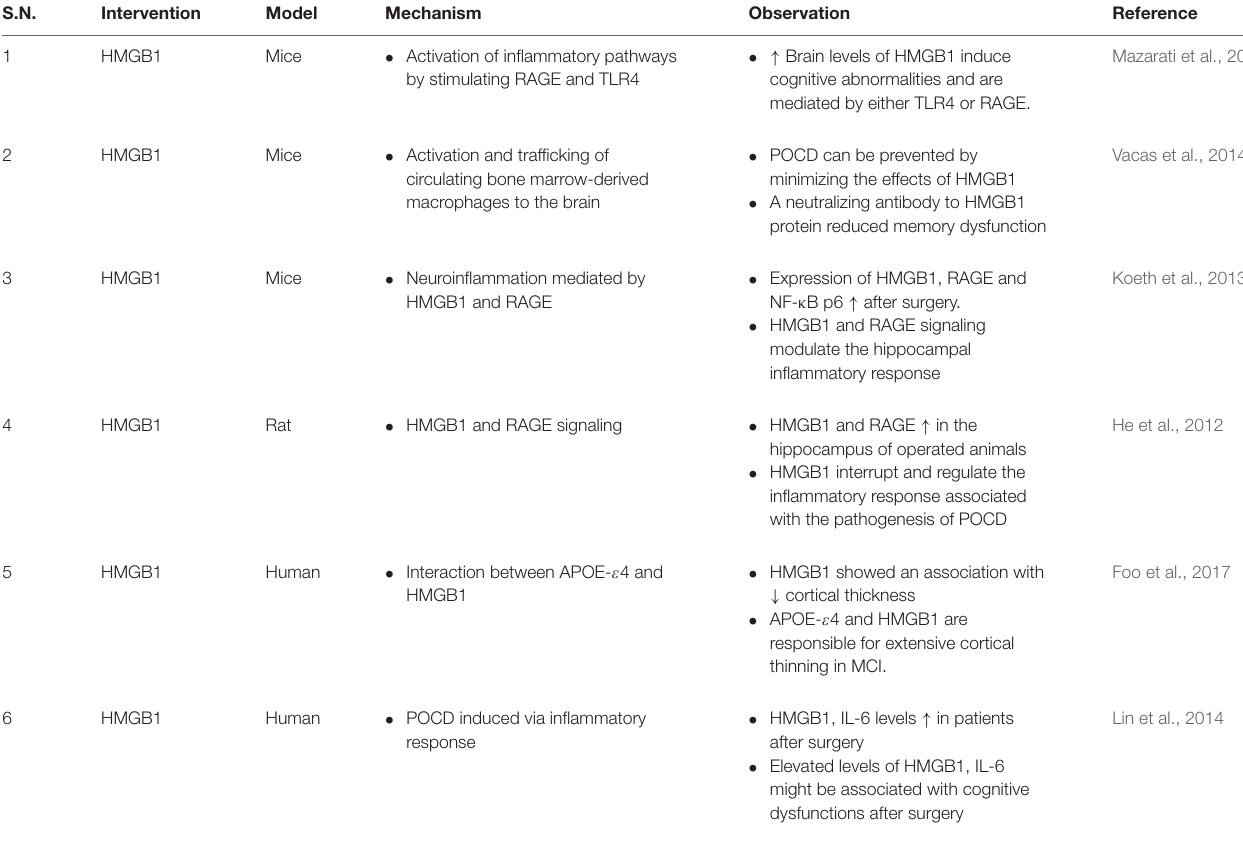
TABLE 4 | Summary of findings reporting HMGB1 in cognitive dysfunction.